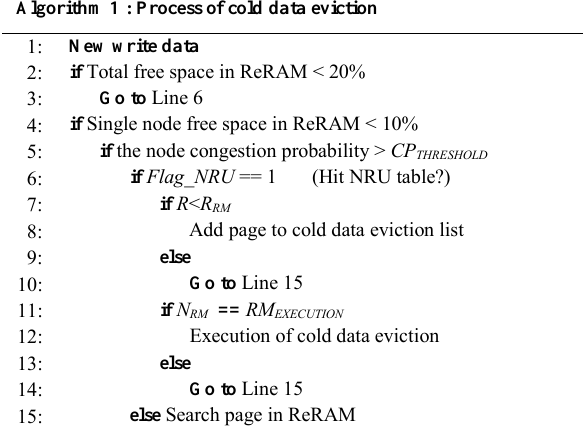
Fig. 5. The overall process of the proposed